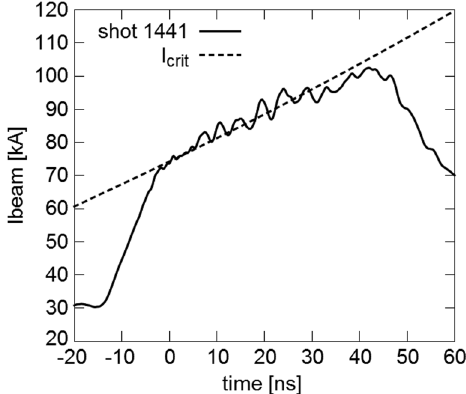
FIG. 18. Theoretical critical current and IBEAM for a time- dependent AK gap. Equation (1) using v ¼ 1 cm = μ s, α ¼ 1 . 1 , and γ ð t Þ ¼ 8 þ 0 . 0625 t where t is in ns. The time axis has been